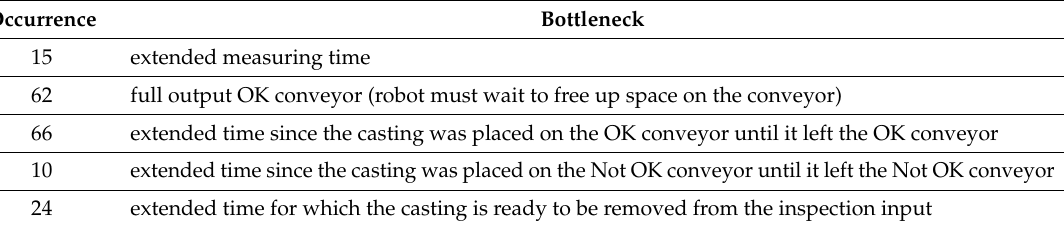
Table 1. Production line bottlenecks